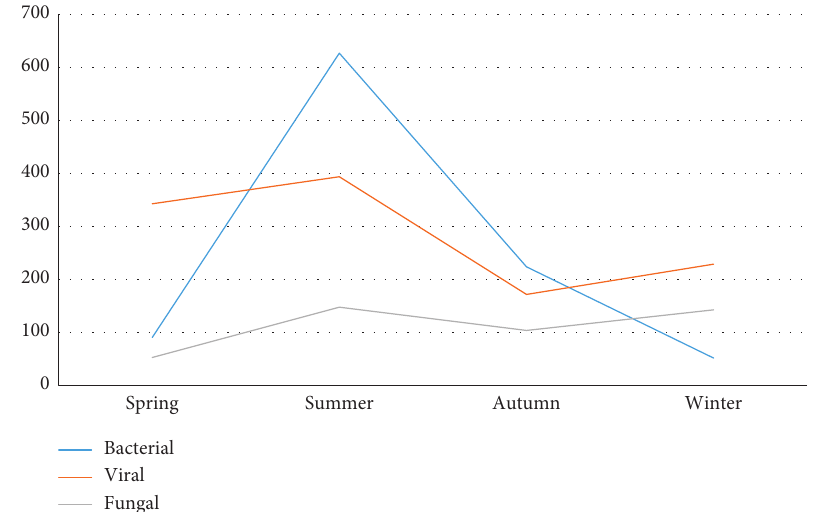
Figure 3: Seasonal variation of different skin infections in the pediatric patients.